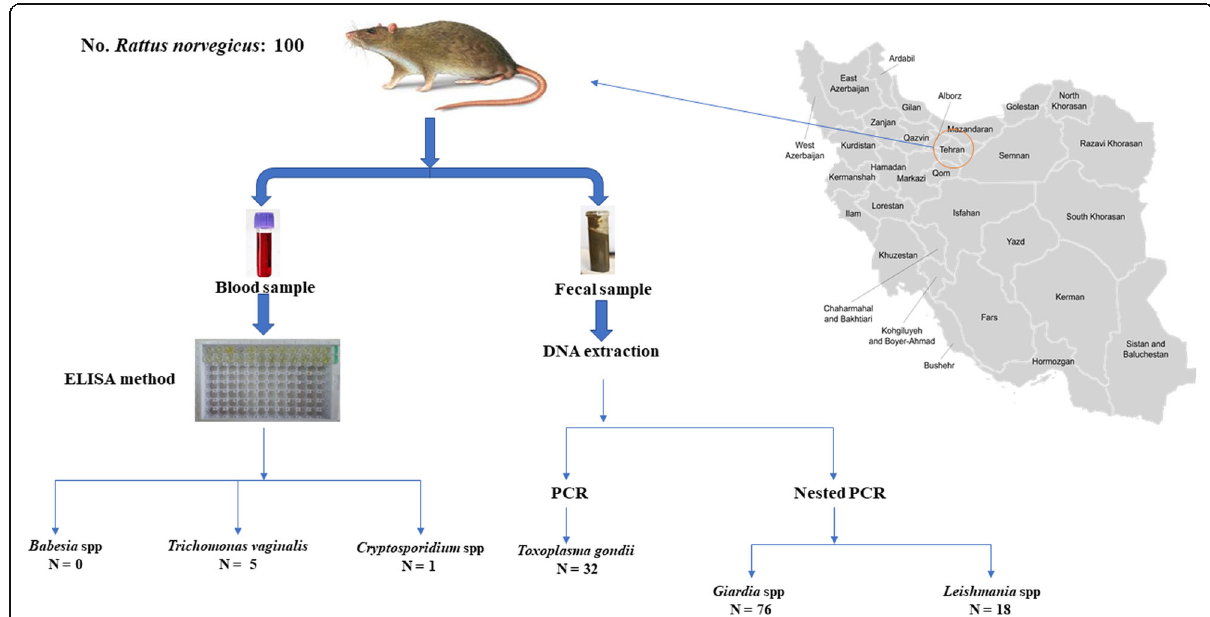
Fig. 1 A schematic map of the region sampling was done and the frequency of each surveyed parasites among the Rattus population in Tehran, Iran